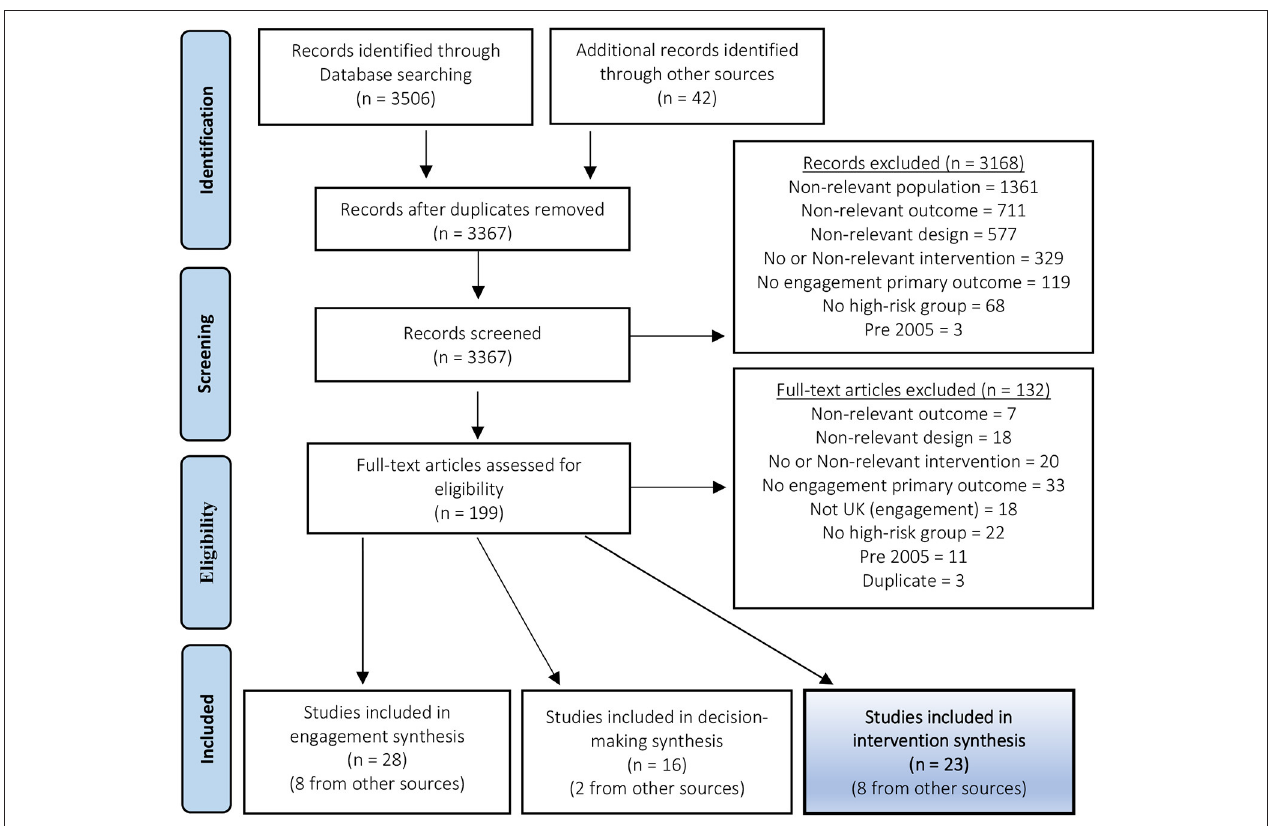
FIGURE 1 | PRISMA flow diagram of literature search and selection